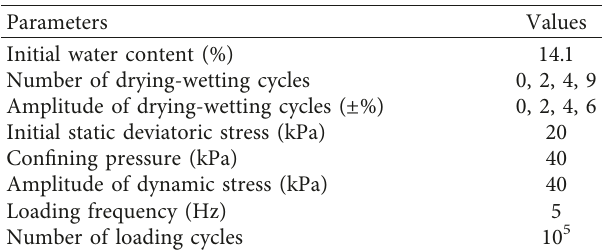
Table 2: Testing program of dynamic load coupled with dry-wet